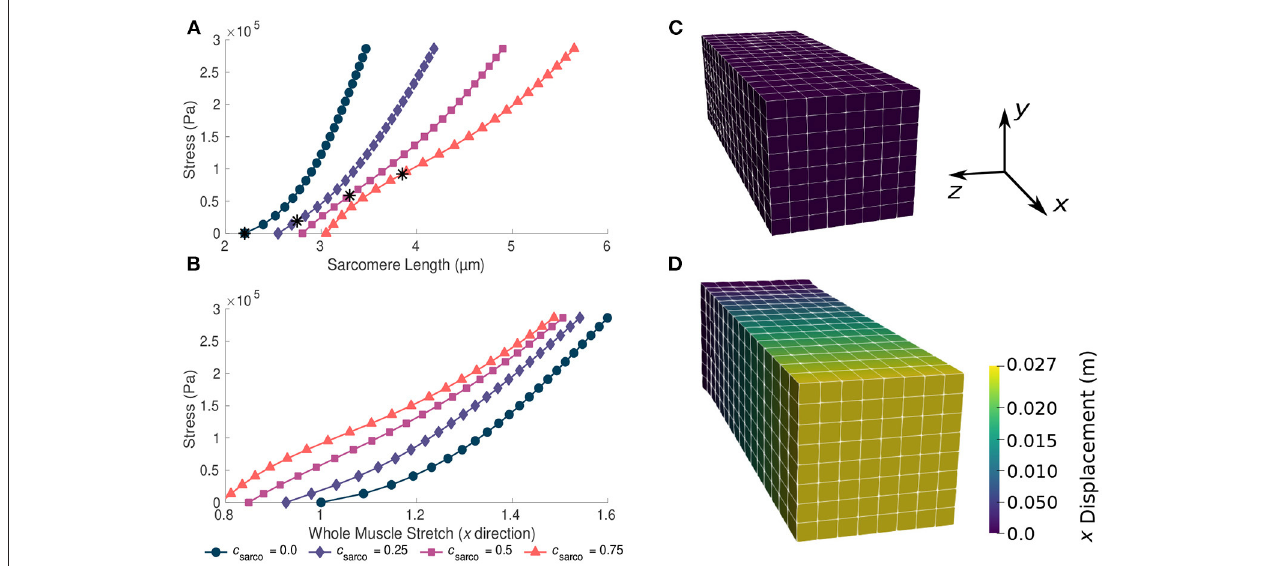
FIGURE 3 | Plots of whole muscle stress in the along fibre direction against sarcomere length (A) and whole muscle stretch (B) . Plots are from the computational model during passive lengthening with ECM volume fraction, α , of 0.05 and ECM stiffness factor, s ECM , of 1.0. Each curve represents a shift in the sarcomere stretch by a factor of c sarco . ∗ represents in vivo sarcomere length for corresponding c sarco . (C,D) show the mesh at resting length and at a deformed state after the stress has been applied to the model.